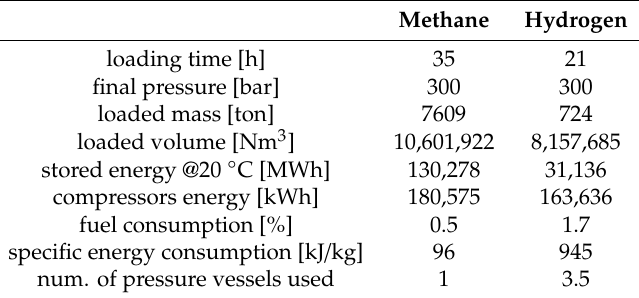
Table 4. Loading process: methane vs. hydrogen.